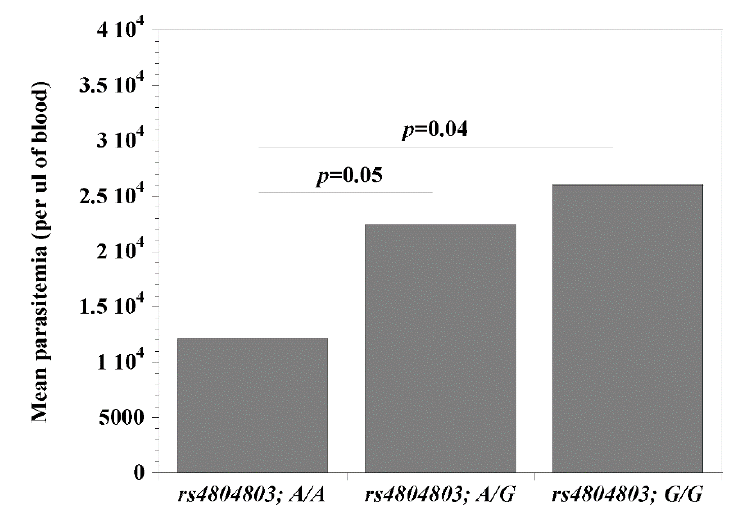
Figure 1. Mean age among malaria patients with CD209 ( snp : -383A > G; rs4804803 ) wild type, heterozygous and mutant variants. Odds ratios were calculated by Fisher’s two-tailed exact tests. A p -value < 0.05 was considered significant.